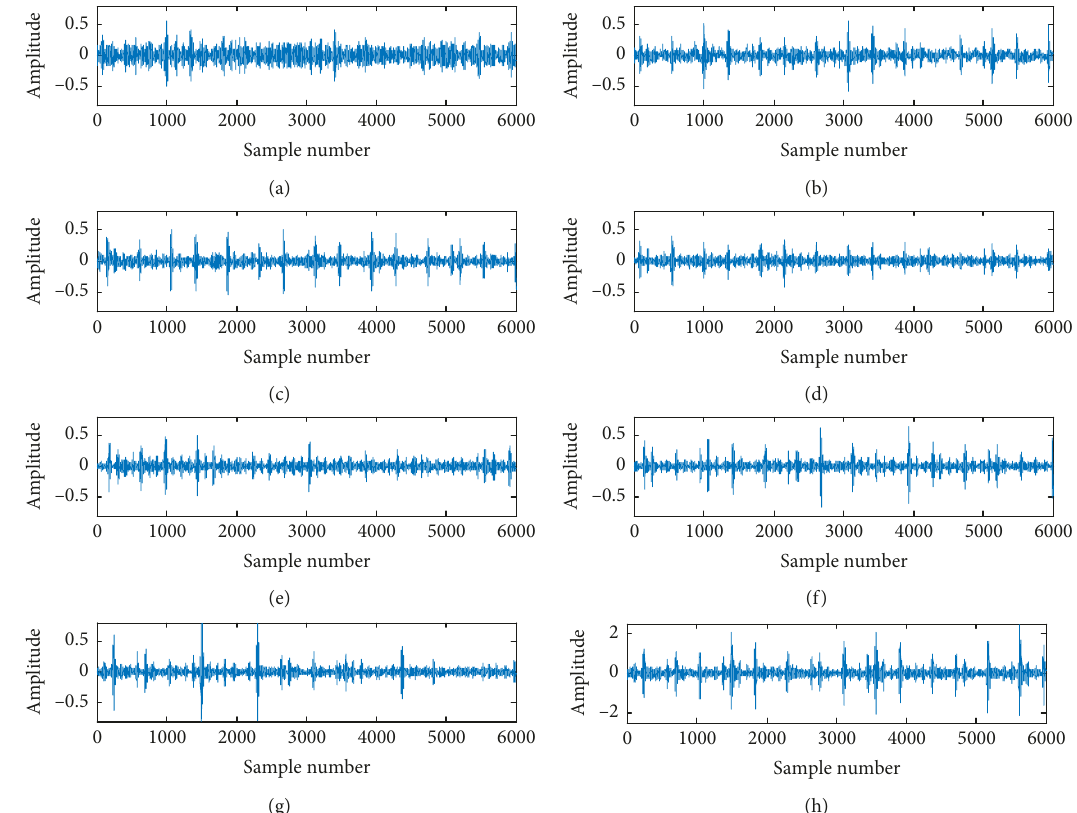
Figure 9: Multiresolution DMD modes of roller bearing’s outer race fault signal